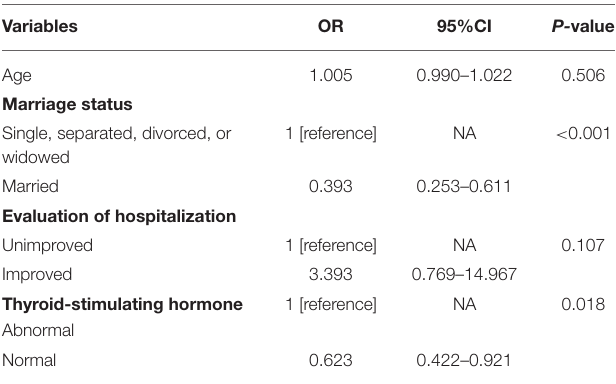
TABLE 3 | Multivariable logistic regression analysis.